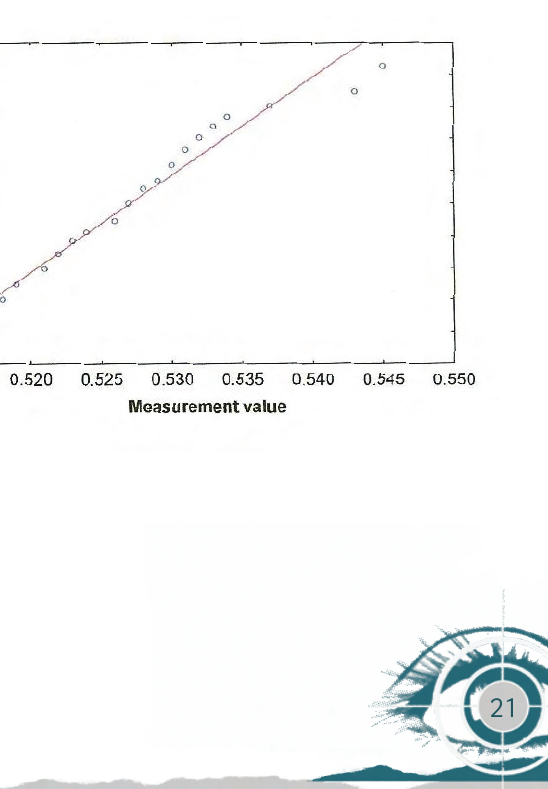
Figure 10. Histogram and normal probability plots for the CCT sample of subject 4. The sample for CCT was not normally distrib- uted (the p -values for the K-S, Lilliefors, and SW-W tests ( p =